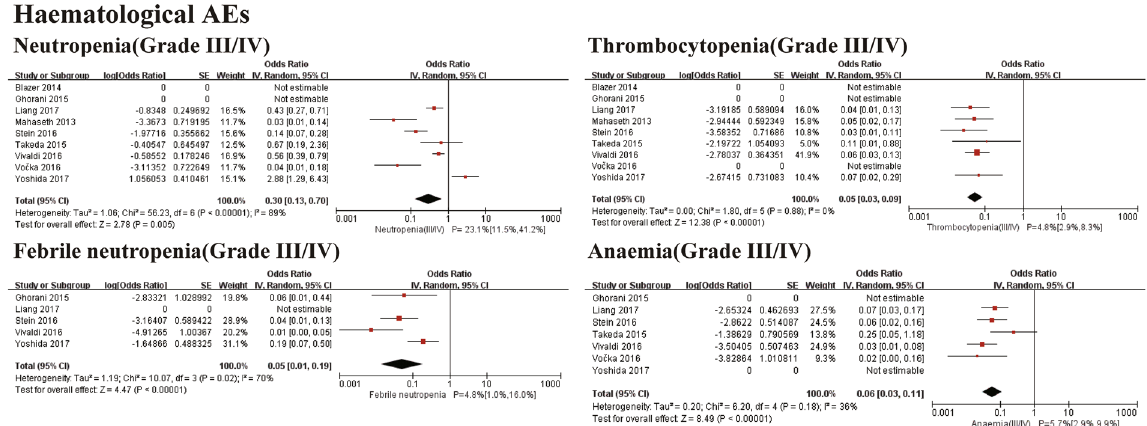
Figure 4. Meta-analysis for adverse events of haematological AEs. SE: standard error. IV: random-model generic inverse variance method. 95% CI: 95% confidence